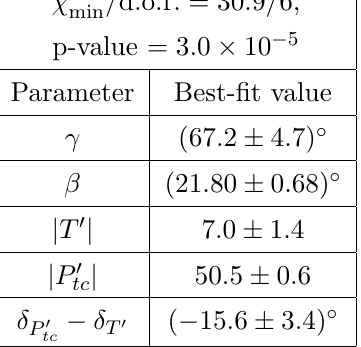
Table 2 . (cid:31) 2 = d : o : f : and best-(cid:12)t values of unknown parameters in amplitudes of eq. (2.6). Con- min straints: B ! (cid:25)K data, measurements of (cid:12) and (cid:13) .